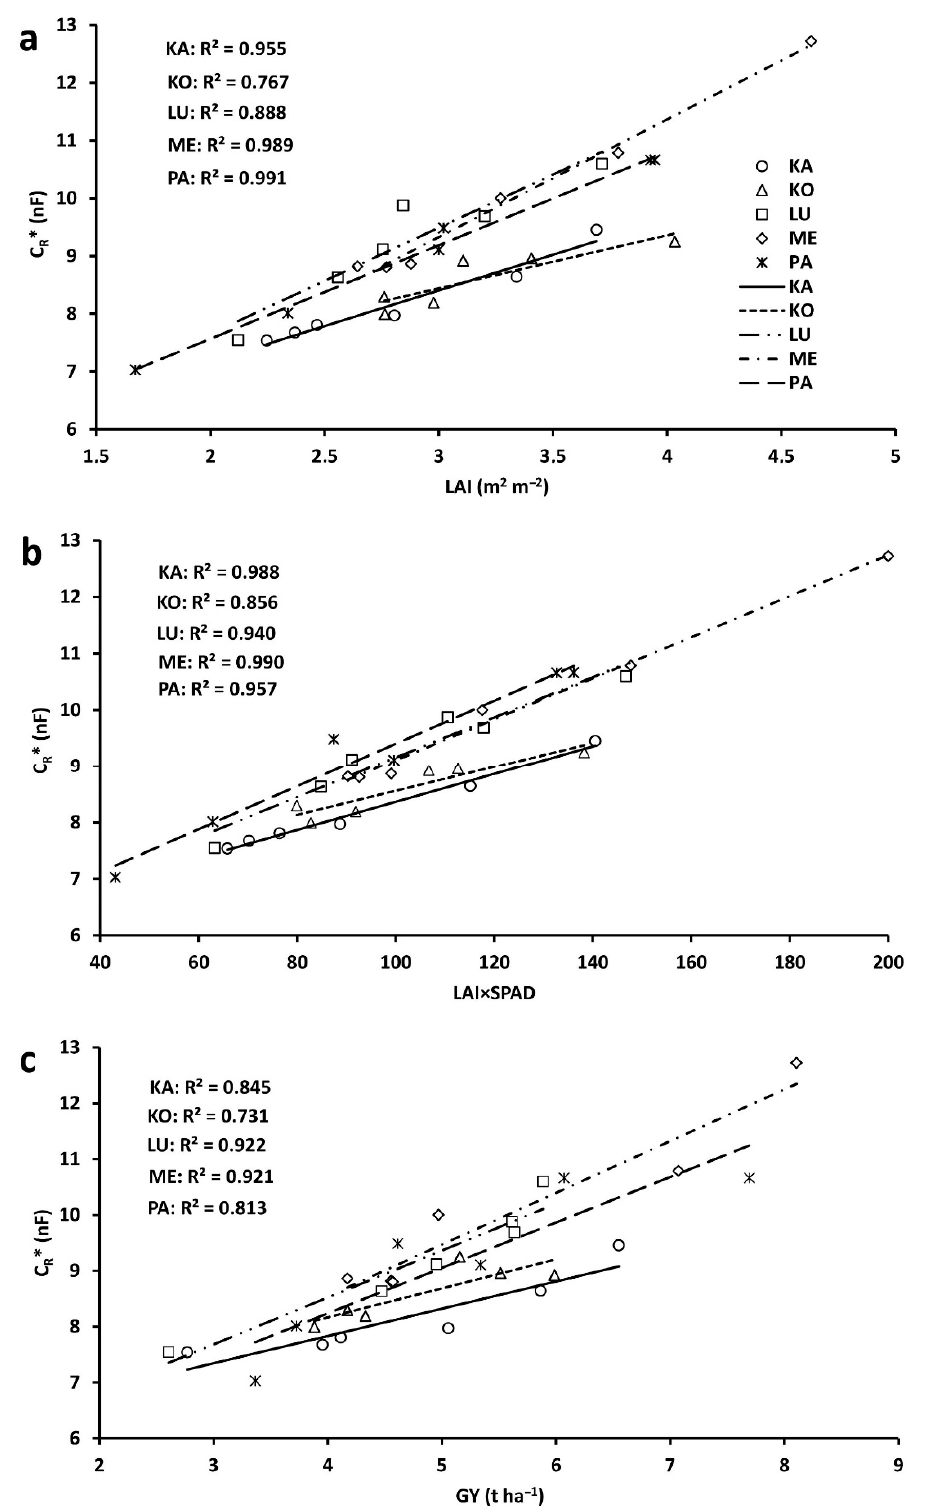
Figure 5. Relationship between the saturation root electrical capacitance (C R *; means of 20 plants from a plot) and ( a ) leaf area index (LAI), ( b ) LAI × SPAD value (chlorophyll quantity in flag leaf), and ( c ) grain yield (GY) for the five wheat cultivars (KA: Káplár; KO: Kolo; LU: Lucilla; ME: Ménrót; PA: Pántlika) grown in three plots. For each cultivar, data were pooled across the two years. All the regressions were significant at p < 0.05 (n = 6).